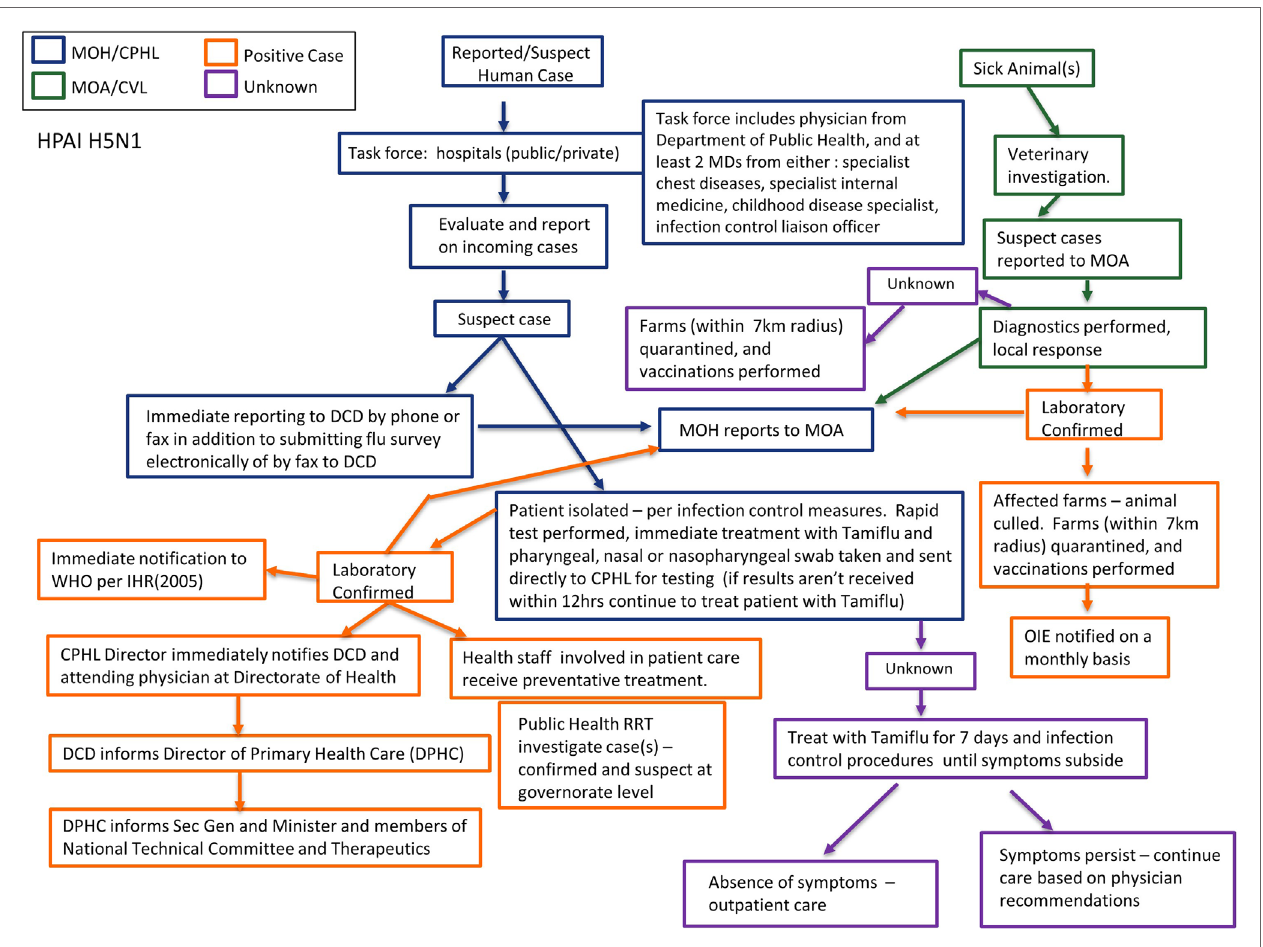
FigUre 3 | surveillance and laboratory mapping of highly pathogenic avian influenza (hPai) h5n1 . Surveillance and laboratory networks for HPAI H5N1, including nodes of communication and response, were mapped across human health and veterinary sectors. Systems were analyzed beginning from report of a suspect case to diagnostic confirmation, including evaluation: case reporting; reporting and sample submission; laboratory testing; case management; and outbreak investigation. Efforts in surveillance and response lead by Ministry of Health are represented in blue while those lead by Ministry of Agriculture are in green. Positive cases are noted in orange while unknown/unconfirmed cases are represented in purple. Abbreviations: MOH, Ministry of Health; CPHL, Central Public Health Laboratory; DCD, Directorate of Communicable Diseases; MOA, Ministry of Agriculture; CVL, Central Veterinary